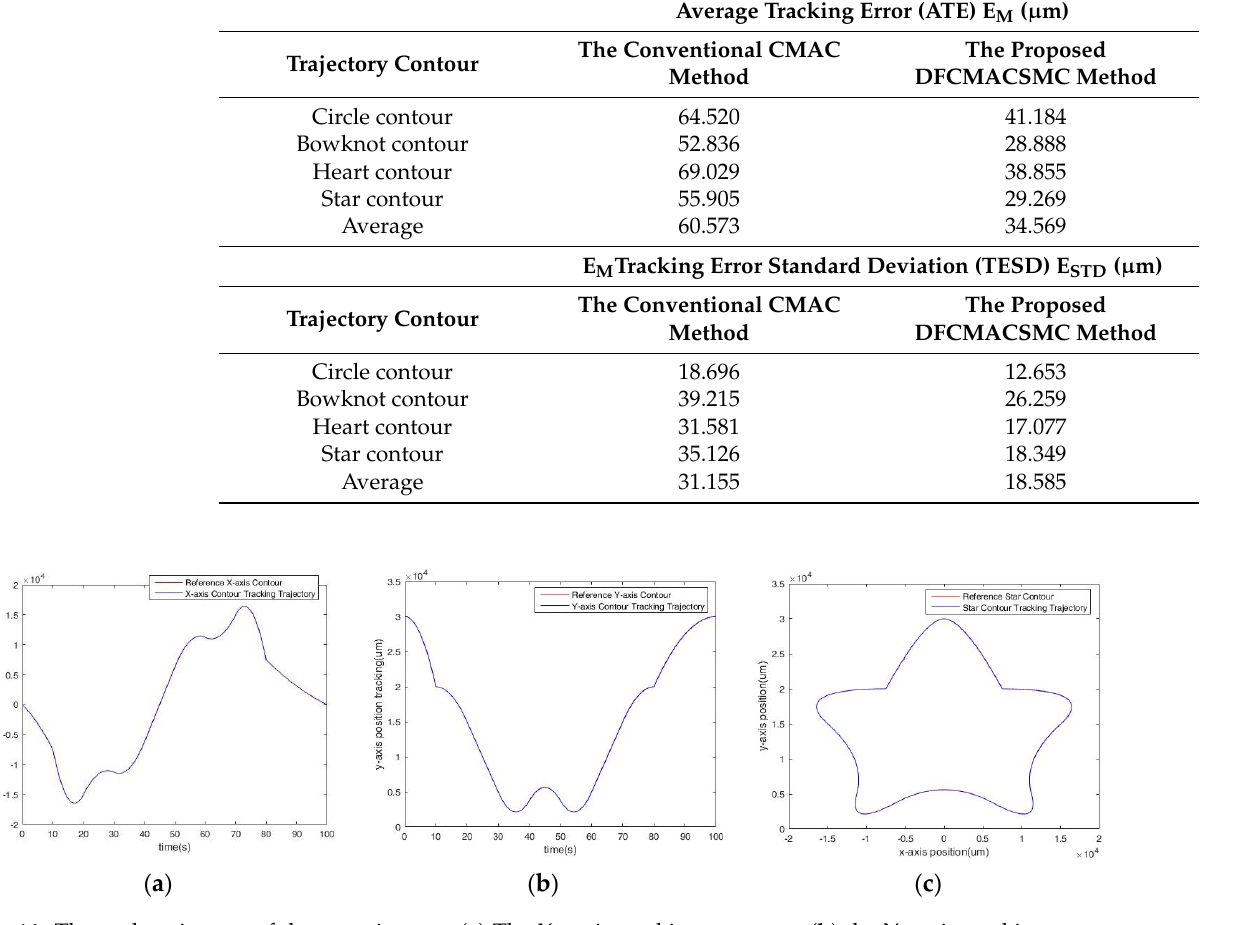
Figure 14. The path trajectory of the experiments. ( a ) The X − axis tracking response, ( b ) the Y − axis tracking response, ( c ) the star path response. Table 3. The experimental results showing contour tracking errors.